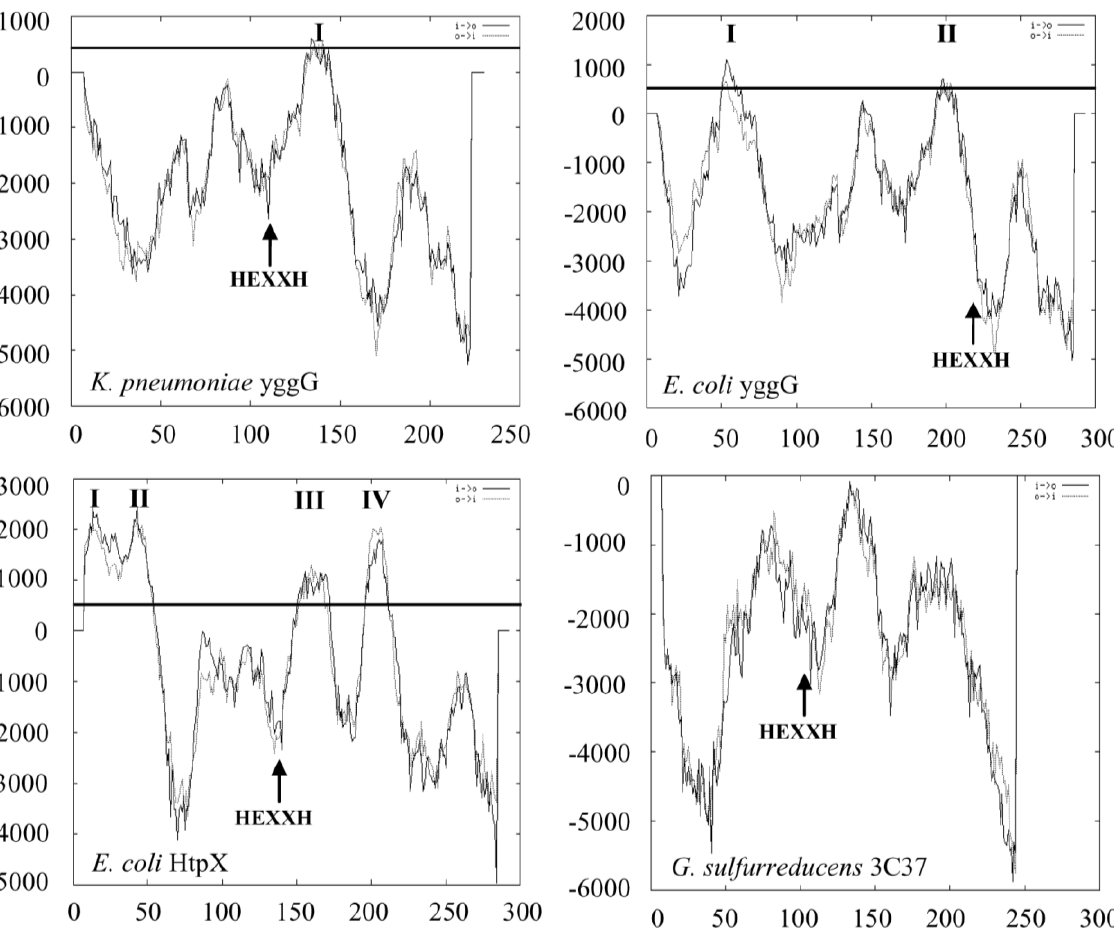
Figure 3. Comparison of transmembrane domains of K. pneumoniae YggG, E. coli YggG, E. coli HtpX and G. sulfurreducens 3C37 as predicted by TMpred. The horizontal line represents the level of hydrophobicity (score ≥500) that predicts membrane-spanning domains with high probability. Predicted transmembrane domains are indicated with Roman numerals. The position of metalloprotease motif (HEXXH) is also indicated. The X axis is the amino acid sequences of the enzyme and the Y axis is the hydrophobicity of the